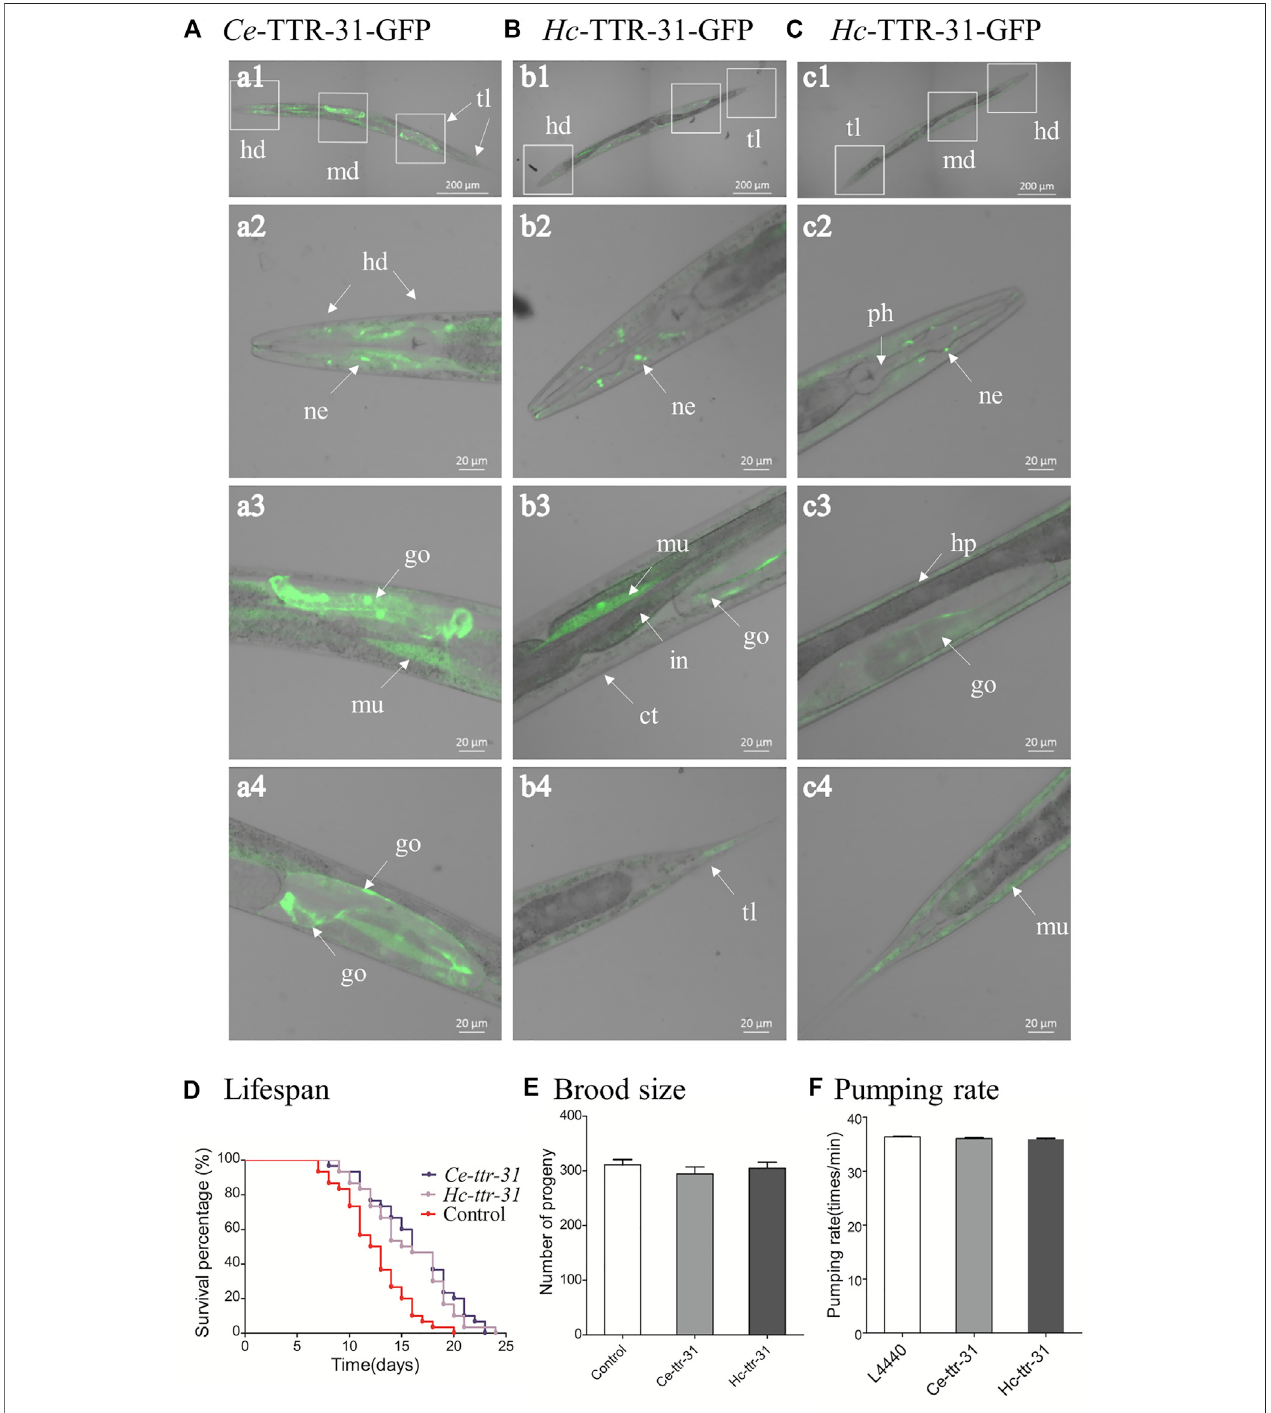
FIGURE 4 | Transgenic expression of Hc-ttr-31 in Caenorhabditis elegans . Green fl uorescence protein-fused Ce- TTR-31 (A) and Hc -TTR-31 (B,C) were expressed in adult worms of C. elegans by microinjection of pPD95.67- Ce-ttr-31p : gfp plasmids. Protein expression in neurons (ne), gonad (go), muscle layer (mu) and hypodermis(hp) areindicated.The in fl uencesofoverexpressedTTR-31 onlifespan (D) ,brood size (E) and pumping rate (F) intransgenic worms areindicated. Dataare presented as mean ± SEM ( n (cid:2) 30, 10, 10). ct: cuticle, hd: head, in: intestine, md: middle, ph: pharynx, tl: tail. Scale bar: 20 μ m or 200 μ m.